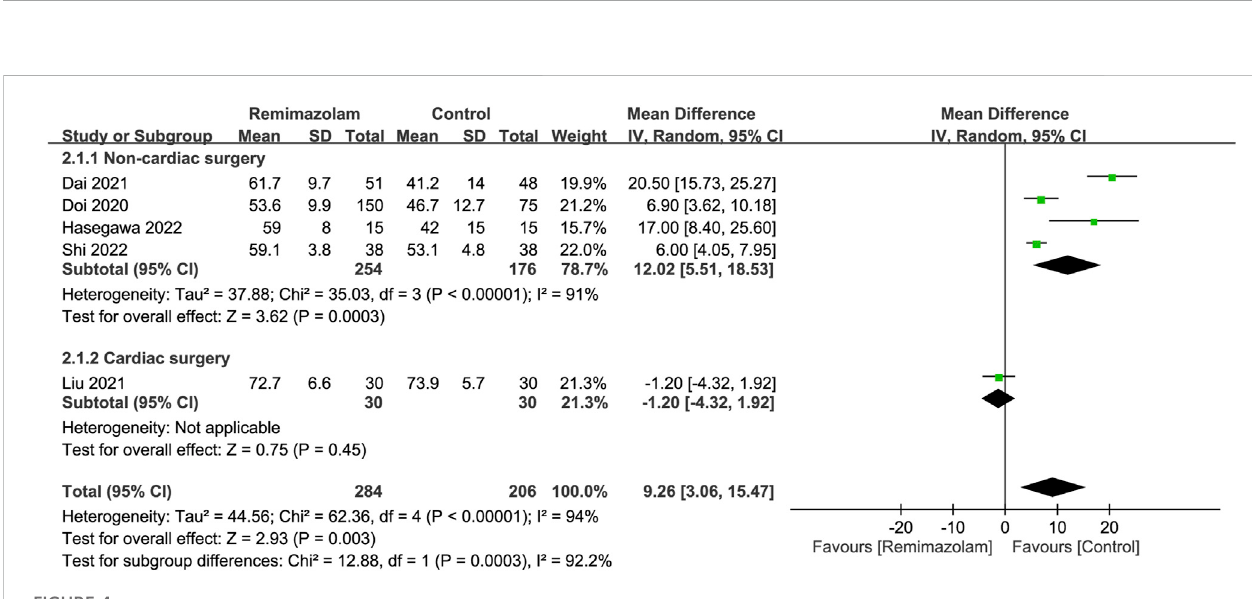
FIGURE 4 Forest plot comparing anesthetic depth between remimazolam and control groups. CI, con fi dence interval; IV, inverse variance.